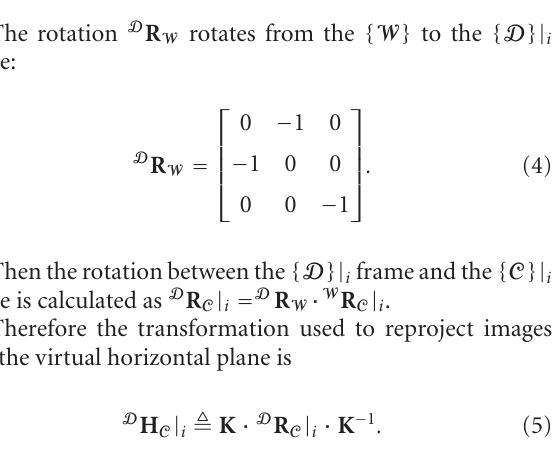
world frame is calculated as the rotation W R C | i = W R I | i · I R C .